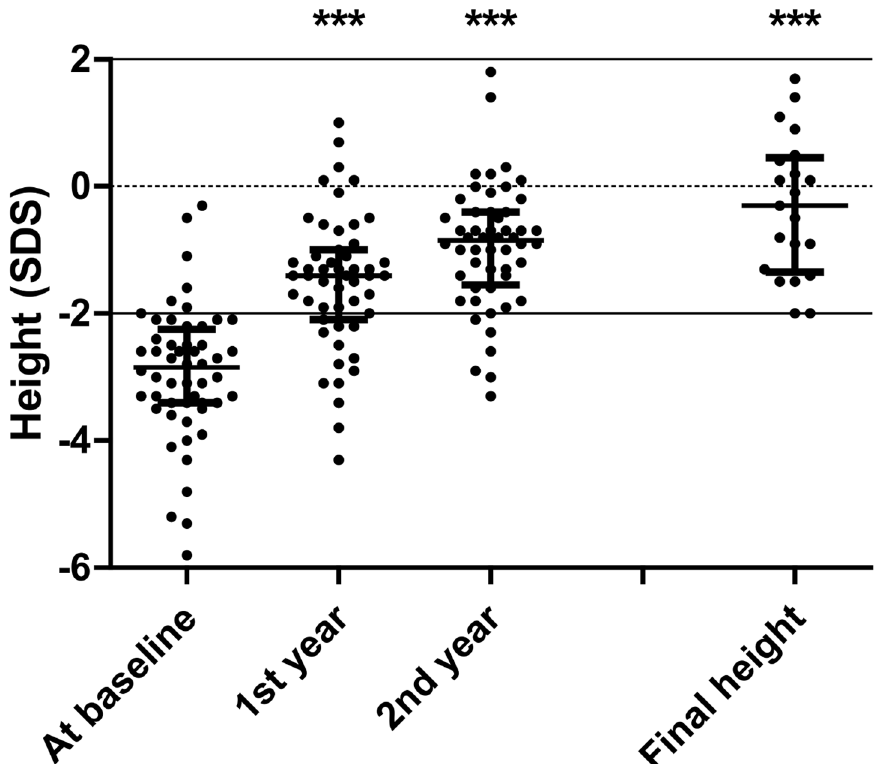
Fig 2. Height SDS during the first 2 years of GH treatment and at final height. Error bars are medians with interquartile ranges. Significant statistical differences between height SDS at baseline and others time points: *** P < 0.0001 (2-way repeated-measures ANOVA plus Bonferroni post-test).